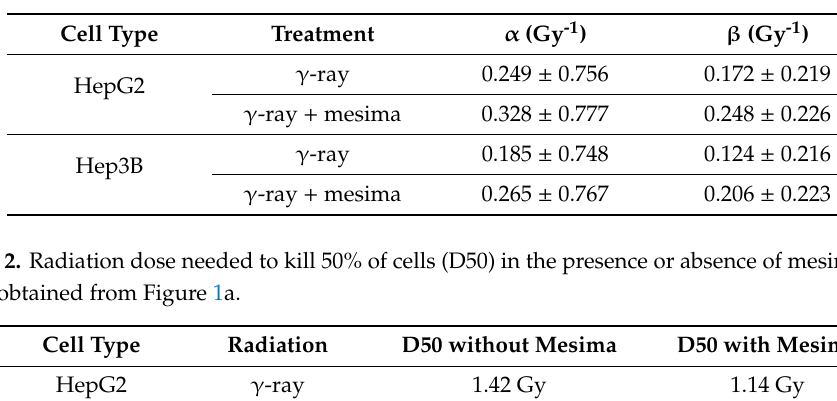
Table 1. Linear quadratic fitting parameters α and β for survival curves in cells irradiated in the presence or absence of mesima and incubated for 14 days.